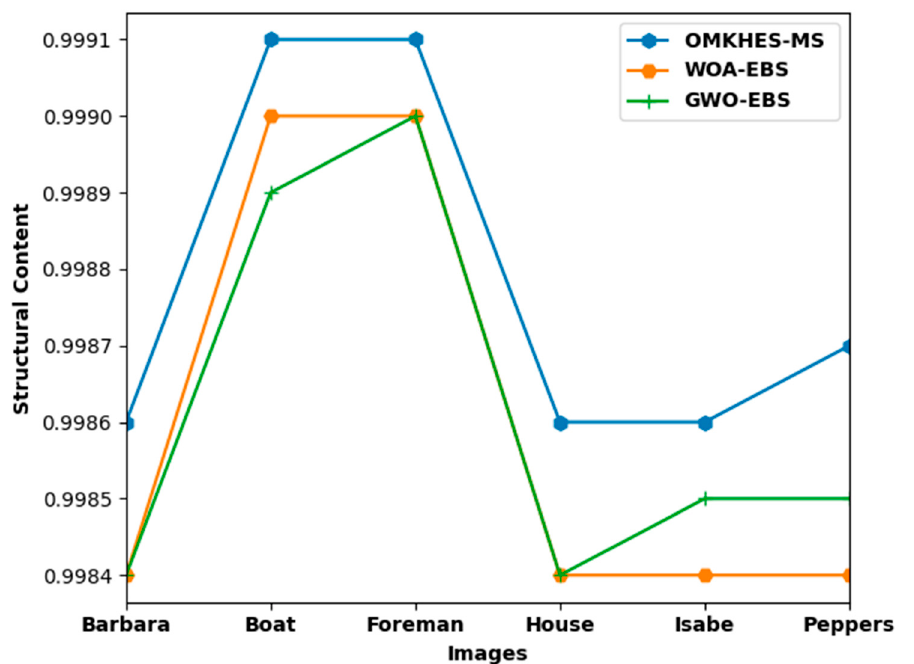
Figure 8. Comparative SC analysis of OMKHES-MS technique with existing models.